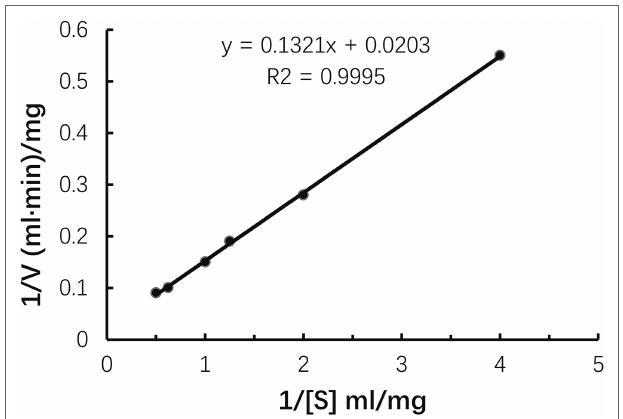
FIGURE 5 | Kinetic parameters of purified recombinant Car1383 with different concentrations of κ -carrageenan substrate (from 0.01 to 0.1 g/L).